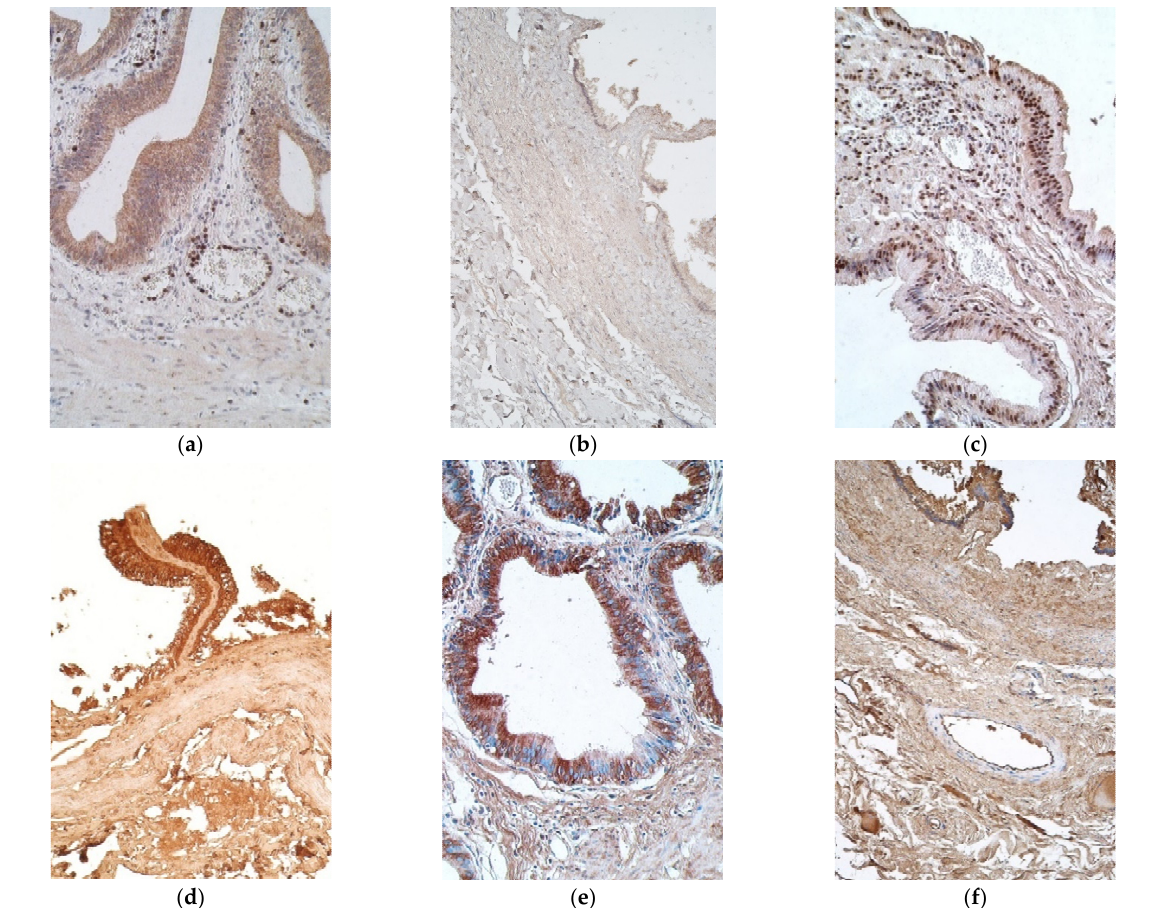
Figure 2. Micrographs of gallbladder in children with cholecystitis and in controls. ( a ) Note a moderate to numerous number of IL-1 α positive epithelial cells along the positive inflammatory cells in the capillaries and subepithelial tissue. IL-1 α IMH, × 200; ( b ) no IL-1 α positive cells were detected in the control. IL-1 α IMH, × 200; ( c ) a moderate number of IL-4 positive cells in the connective tissue. IL-4 IMH, × 200; ( d ) note numerous IL-4 positive epitheliocytes and a lack of IL-4 positive cells in the connective tissues of control. IL-4 IMH, × 200; ( e ) numerous IL-6 containing epitheliocytes in a patient. IL-6 IMH, × 200; (f) control samples with also numerous IL-6 positive epithelial cells. IL-6 IMH, ×